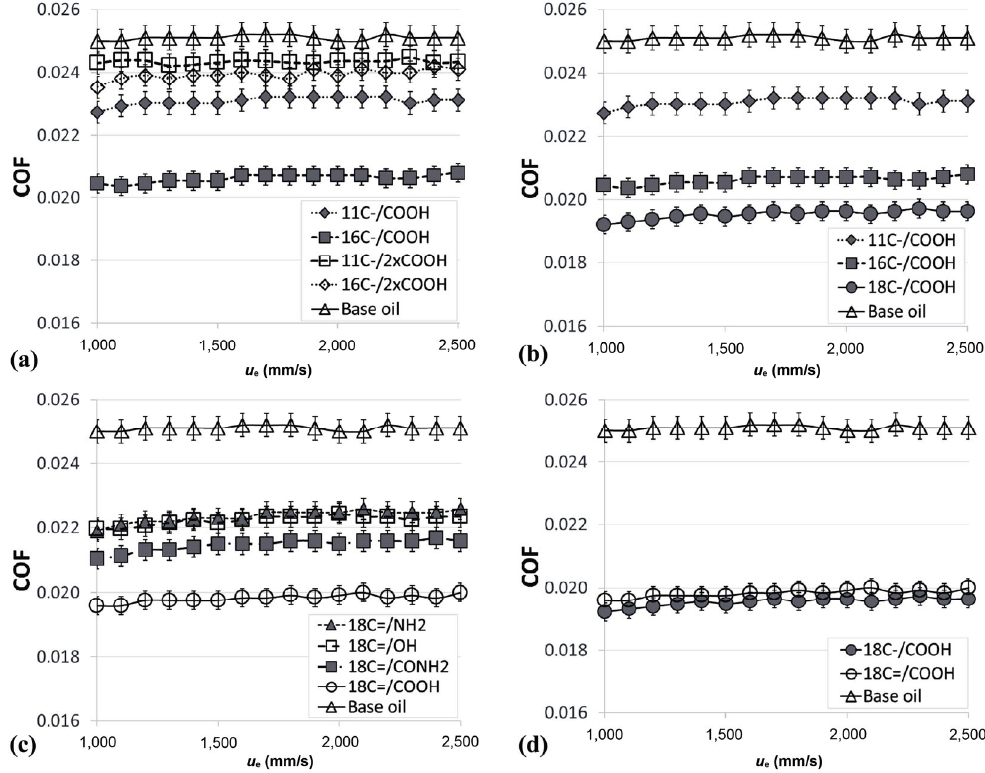
Fig. 3 EHD friction at 100 ℃ depending on additive variation of the (a) number of COOH groups; (b) alkyl chain length; (c) functional groups polarity; and (d) saturation.